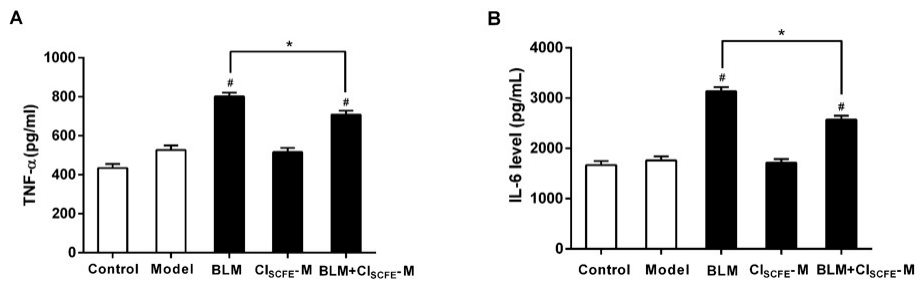
Figure 6. Effect of CI SCFE on BLM-induced cytokines productions in lung tissues. The activities of tumor necrosis factor-alpha (TNF- α ) ( A ); and interleukin (IL-6) ( B ) in lungs are presented as the mean ± SEM ( n = 8). # p < 0.05 vs. model group; * p < 0.05 vs. BLM group.